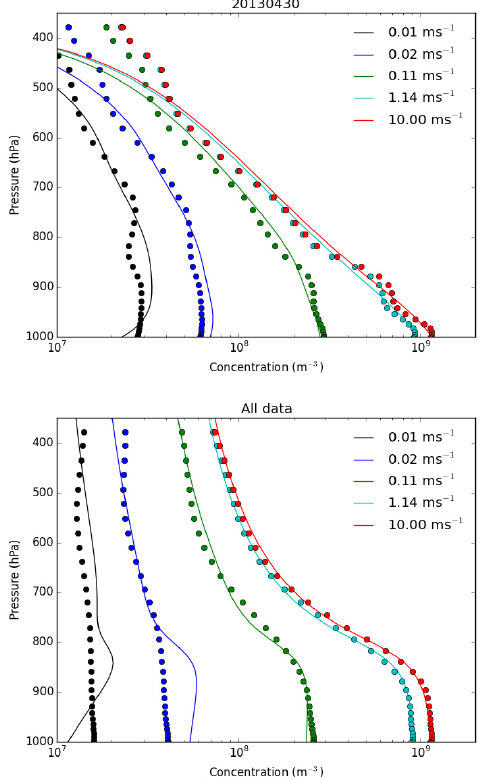
Figure 8. Modelled (circles) and parameterized (lines) CCN con- centrations at multiple vertical velocities for 30 April 2013 (top) and all data (bottom).